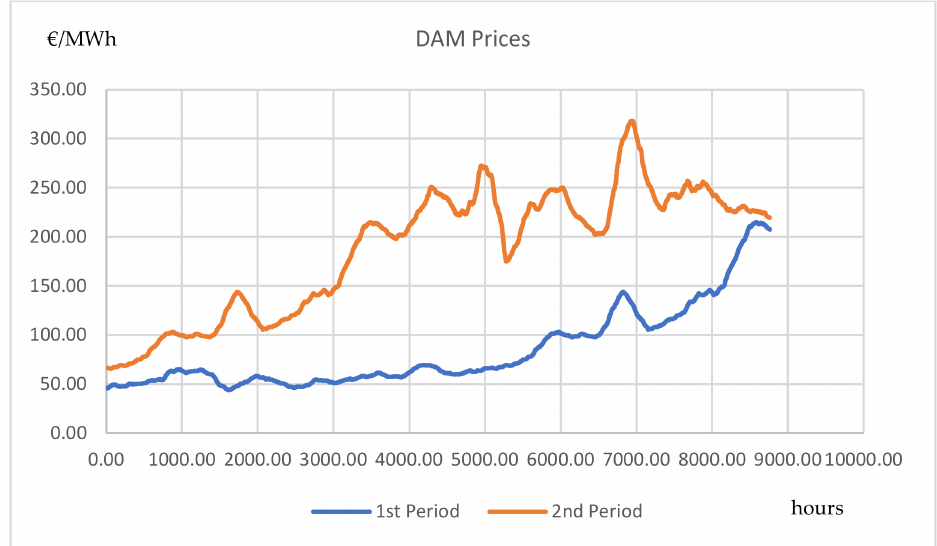
Figure 7. DAM prices during the 2 periods ( €